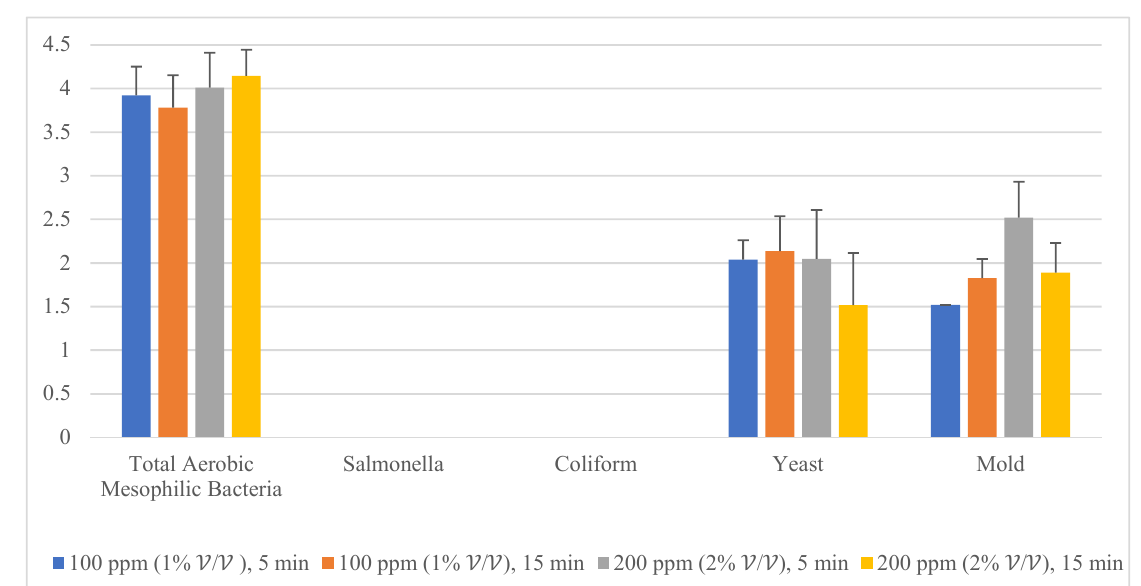
Figure 3. Total reduction of microbial load (log10 CFU/cm 2 ) after quat sanitizer treatment.